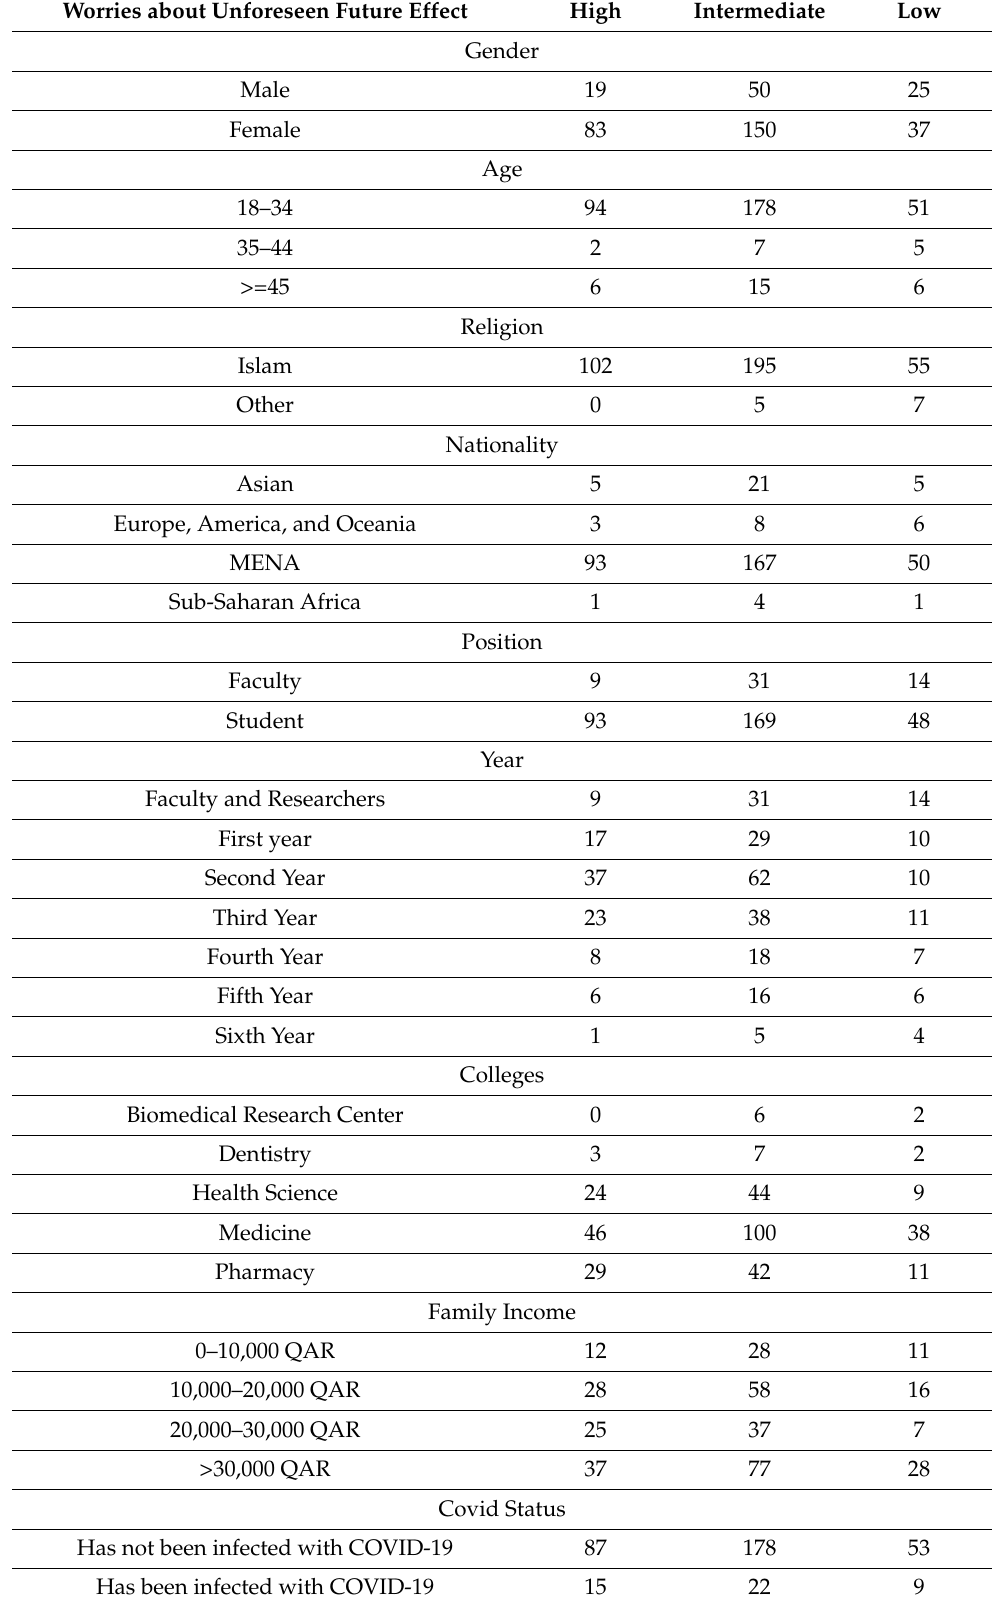
Table A4. Actual number of participants in Worries About Unforeseen Future Effect